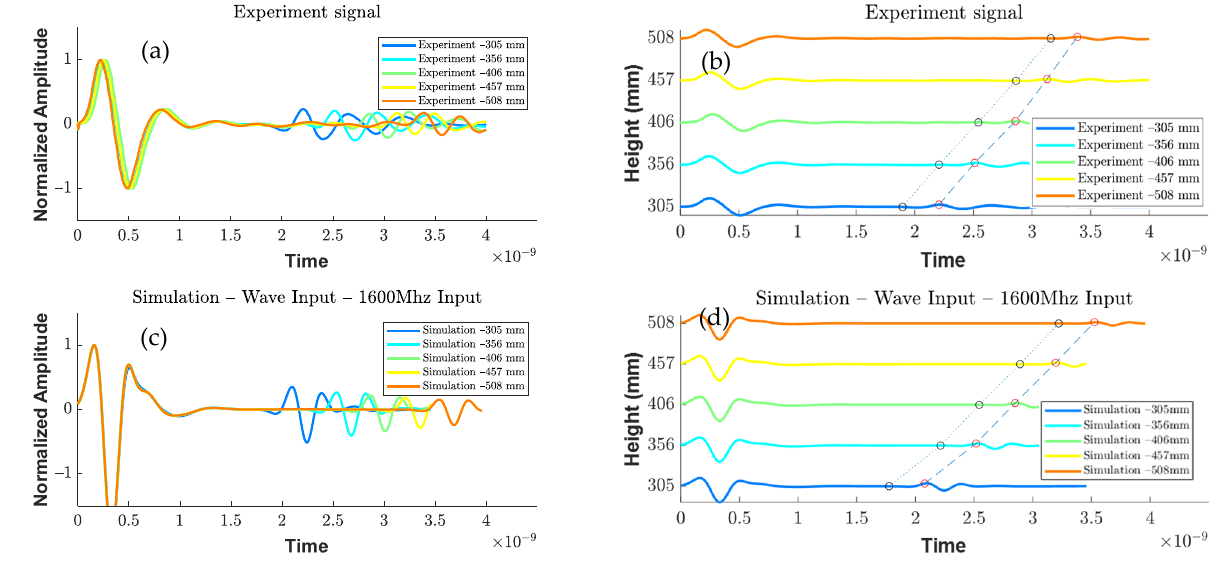
Figure 9. Data comparison: wave response analysis in air at different depths (305–506 mm) for ( a ) experiment and ( c ) simulation, and waterfall plots for peak amplitude and boundary of metal reflection from ( b ) experiment and ( d ) simulation.